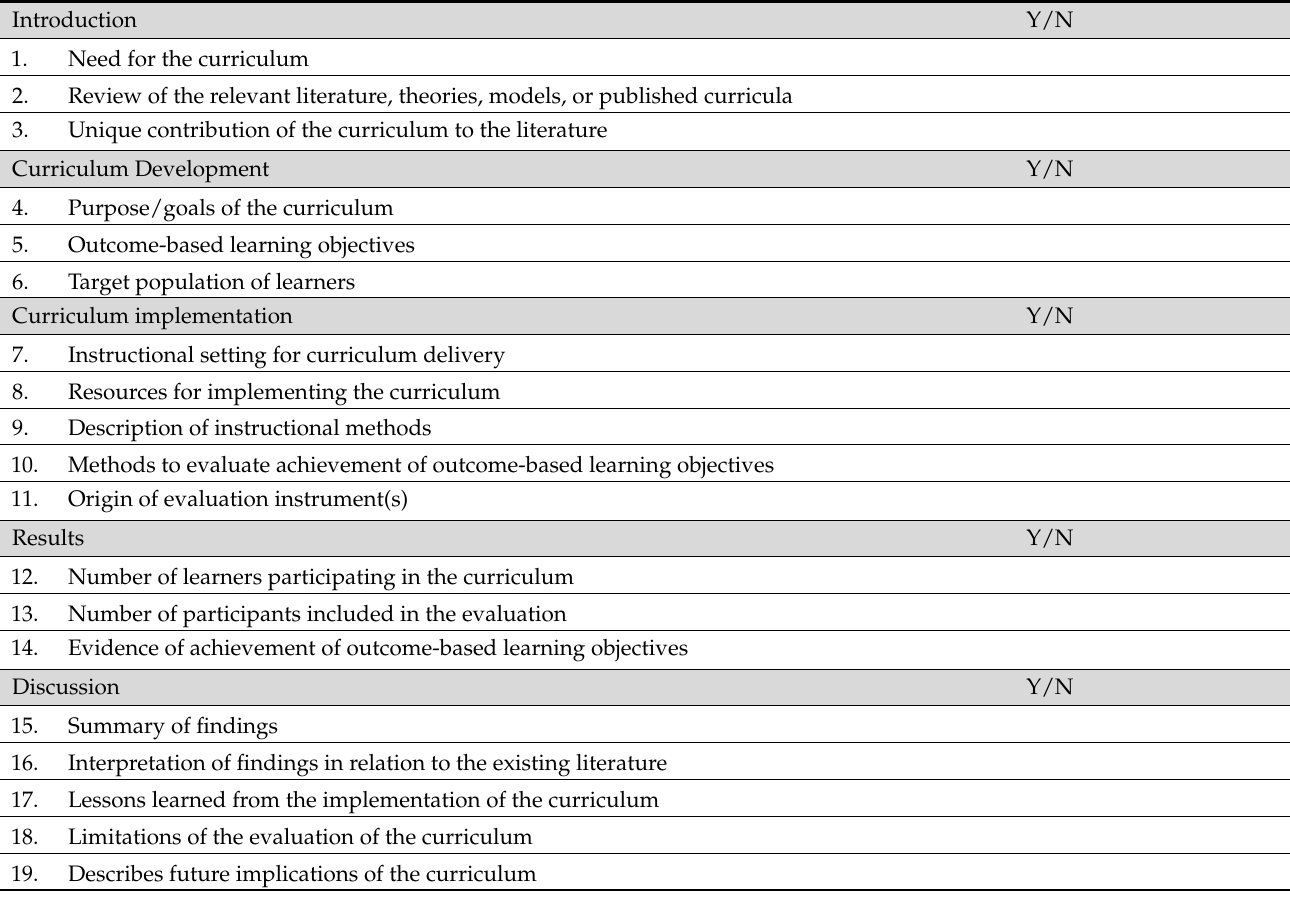
Table 4. Defined Criteria to Report INnovations in Education